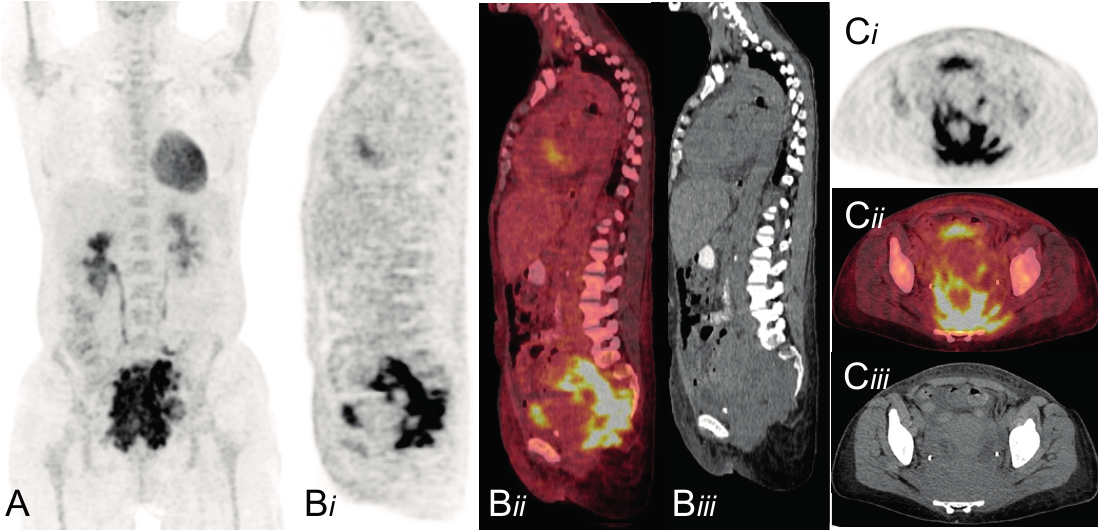
Figure 1. A 44-year old woman with several months’ history of dysmenorrhea, obstipation, and low back pain was examined. The patient’s history and ultrasonographic findings, with the ovaries adherent to the uterus and possible endometriomas, were suggestive of endometriosis. Additionally, an intrauterine device (IUD) was in place, which had not been replaced in 19 years. Six weeks after the initial consultation, the patient returned with oedema of the lower abdomen and legs, weight loss, and fatigue. The IUD had been removed. Laboratory findings showed erythropenia, leucocytosis, elevated C-reactive protein, and creatinine. Renography showed bilateral urinary tract obstruction and JJ-catheters were implanted. An F-18 fluoro-deoxyglucose (FDG) PET/CT scan with oral but no intravenous contrast, primarily planned to rule out ovarian carcinoma, was performed. PET-CT ( A Maximum intensity projection. B i - iii Sagittal projection; PET, fused and CT scan respectively. C i - iii Transverse projection; PET, fused and CT scan respectively) revealed a diffusely infiltrative, FDG-avid (SUVmax 18, 0), pelvic mass mainly located in the pre-sacral region extending around the vagina, the intestines and through the greater sciatic foramen intermuscularly on the left side ( C i , C ii , arrow). Subcutaneous oedema of the lower part of the body is seen on CT ( B iii , C iii ). The red bone marrow is seen with diffuse high uptake consistent with anemia and infection ( A ). Based on PET/CT